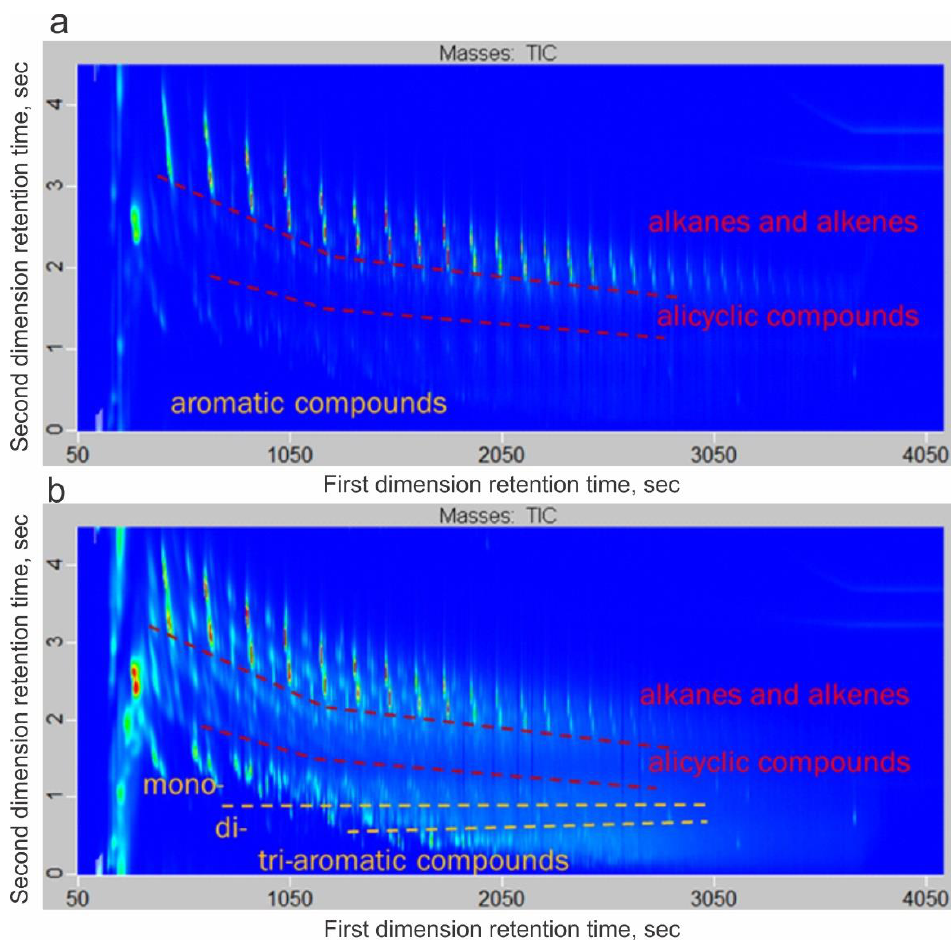
Figure 9. Two-dimensional total ion chromatograms (TIC) of kerogen cracking products for the alginite-rich layers ( a ) and host rocks ( b ).